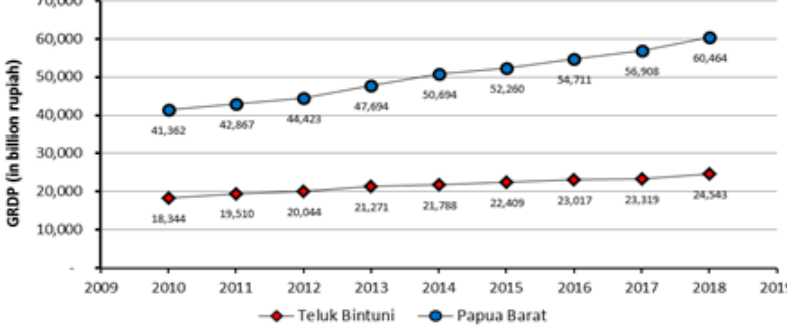
Figure 1: Comparison of GRDP between Teluk Bintuni Regency and Papua Barat Province Source: BPS